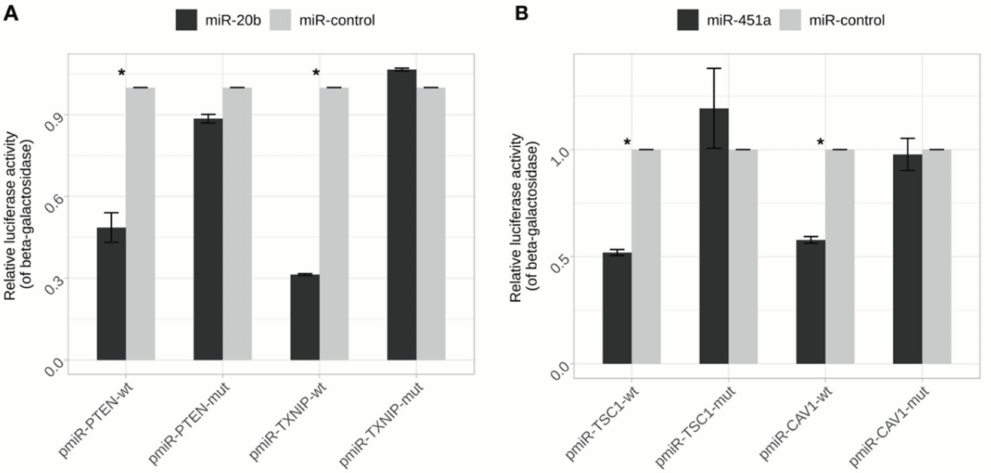
Figure 8. Estimation of direct interaction of investigated miRNAs and predicted target genes 3 (cid:48) UTR by luciferase reporter assay. ( A ) AGS cell line was cotransfected with miR-20b (or miR-control) and pmiR-PTEN-wt / mut or pmiR-TXNIP-wt / mut vectors. Significant signal decrease was determined in cells transfected with either PTEN or TXNIP wt vectors (* p < 0.05); ( B ) AGS cell line was cotransfected with miR-451a (or miR-control) and pmiR-CAV1-wt / mut or pmiR-TSC1-wt / mut vectors. Significant signal decrease was determined in cells transfected with either CAV1 or TSC1 wt vectors (* p <